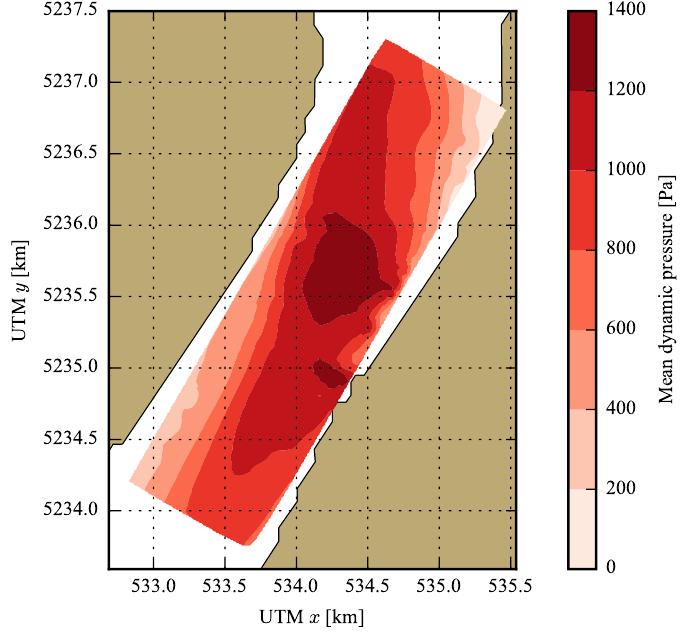
Figure 10. Mean dynamic pressure of the input velocities for the Tacoma Narrows DTOcean model. Extreme values must be supplied for the design of subsea and surface-piercing